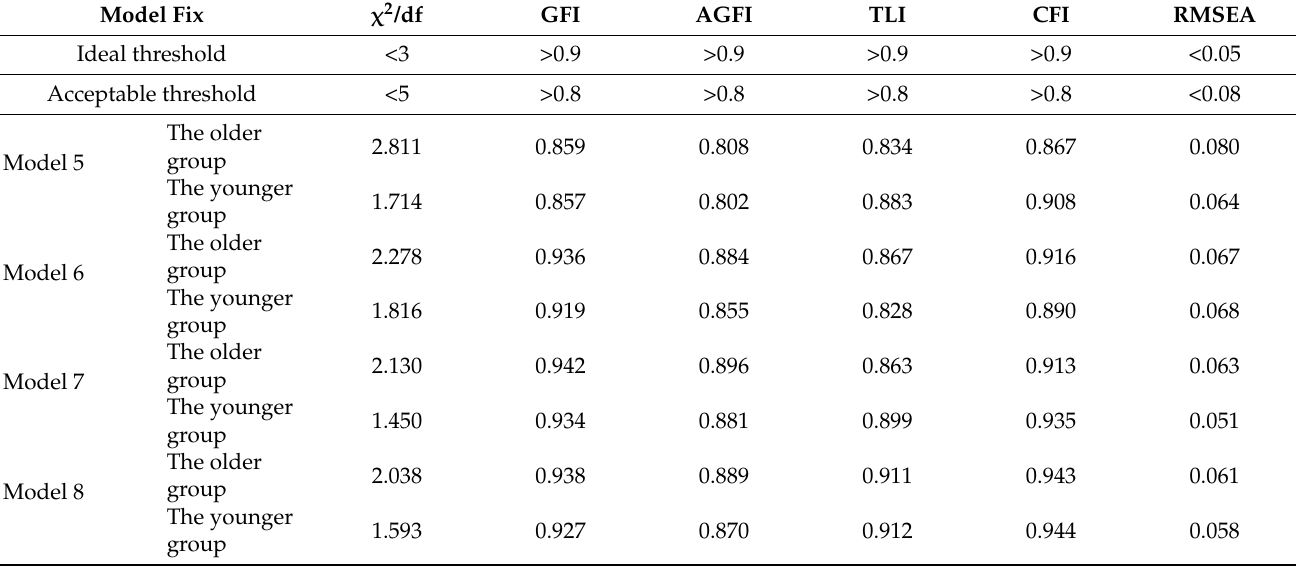
Table 5. Model fit indices of model